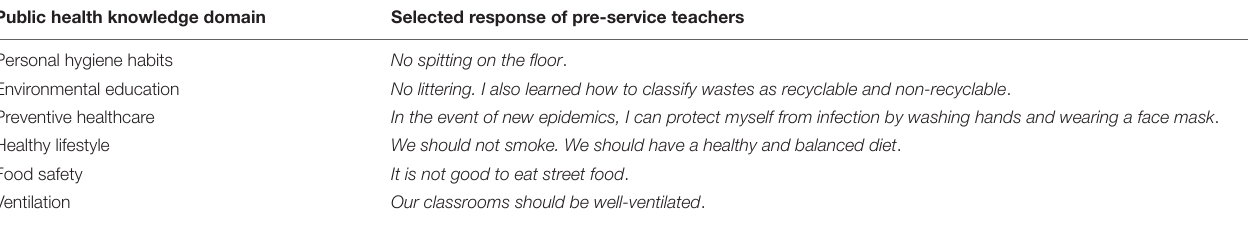
TABLE 1 | Examples for pre-service teachers’ prior knowledge in public health. Public health knowledge